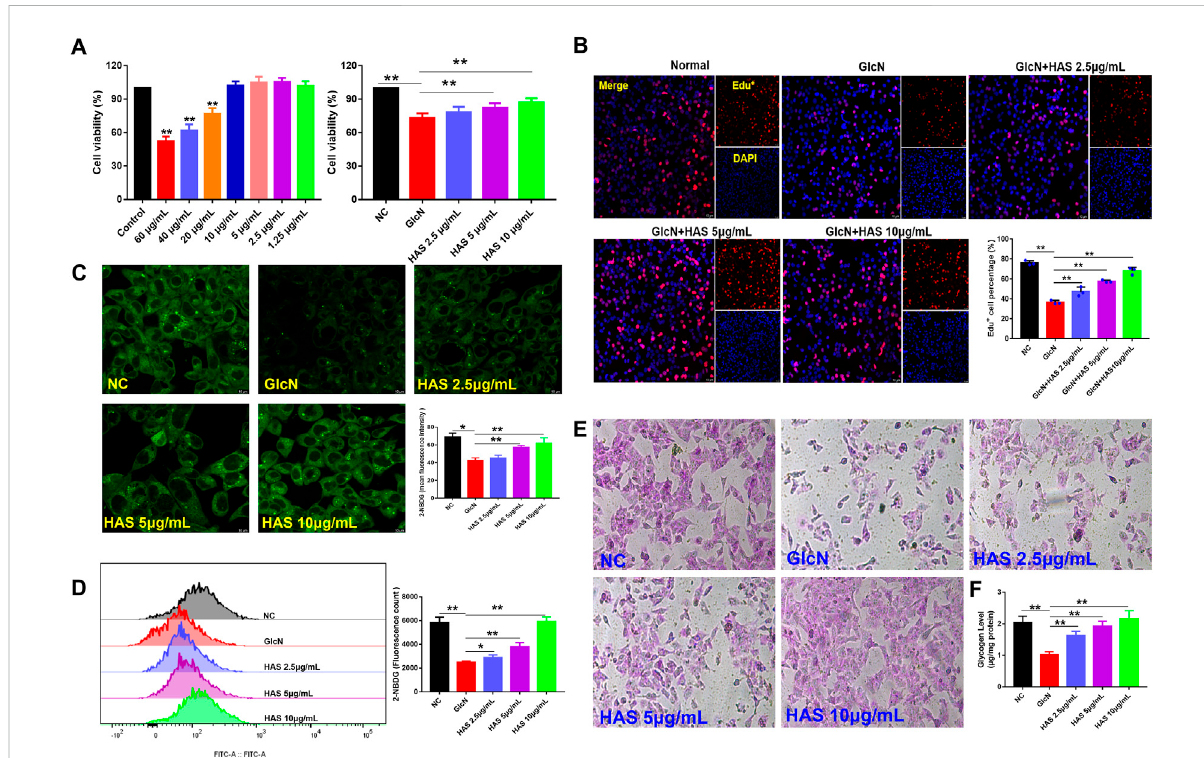
FIGURE 4 Effects of HAS on cell viability and glycogen content of GlcN-induced HepG2 cells. (A,B) HAS increased the viability of GlcN-induced HepG2 cells. (C,D) HAS increased the glucose uptake of GlcN-induced HepG2 cells, as visualized using the fl uorescent glucose analogue 2-NBDG. (E,F) HAS increased the glycogen content in GlcN-induced HepG2 cells. Data are expressed as mean ± SD ( n = 3), * p < 0.05, ** p < 0.01 vs. GlcN- induced HepG2